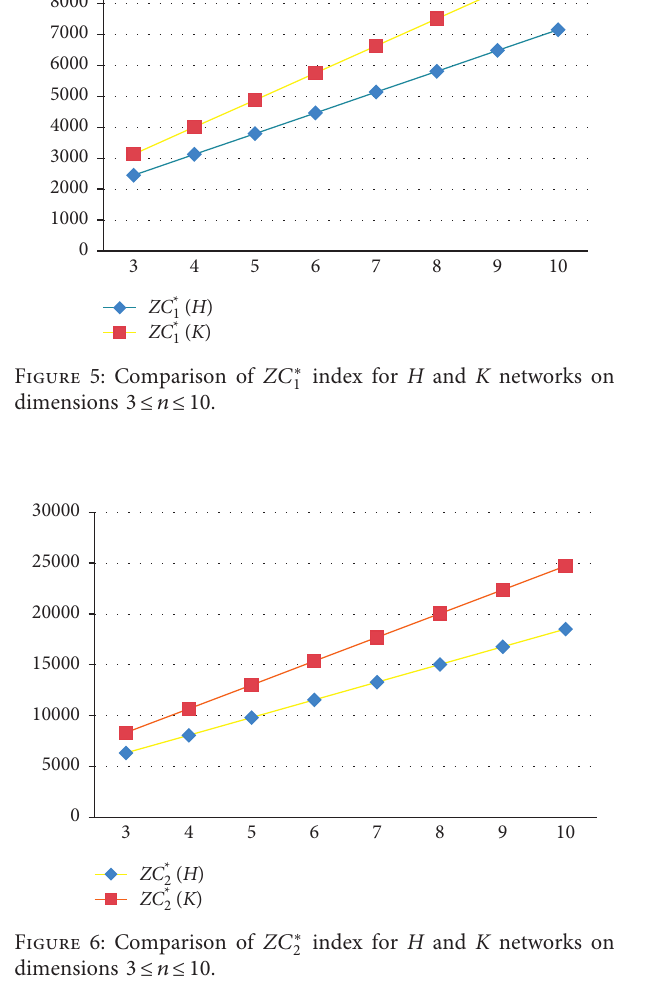
Figure 4: Comparison of ZC dimensions 3 ≤ n ≤ 10.